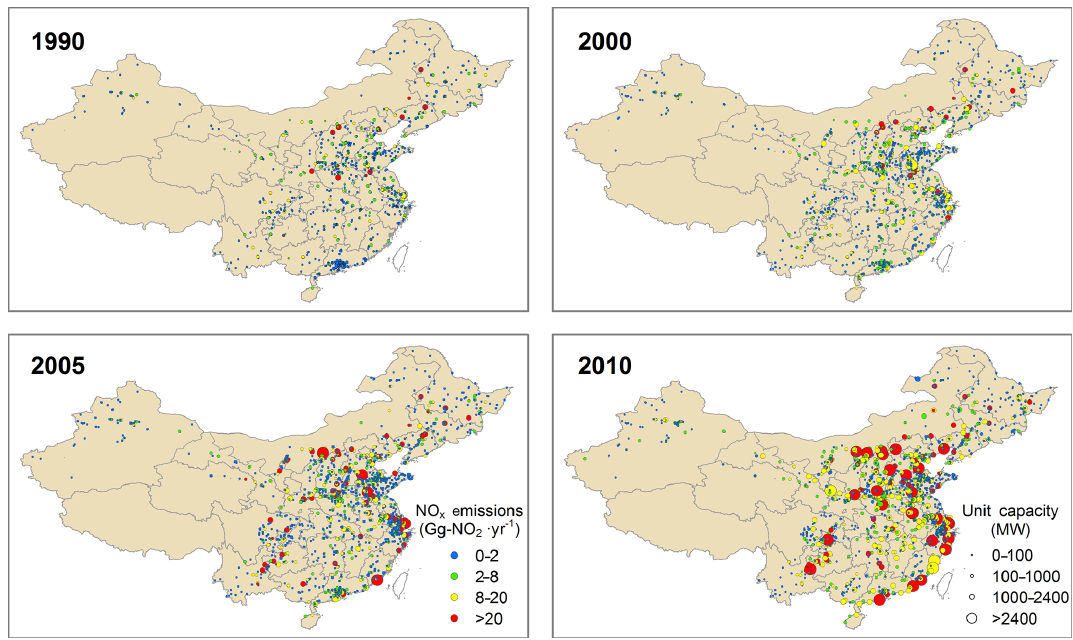
Figure 10. Spatial distribution of NO x emissions from China’s coal-fired power plants in 1990, 2000, 2005, and 2010. Units: Gg-NO 2 yr − 1